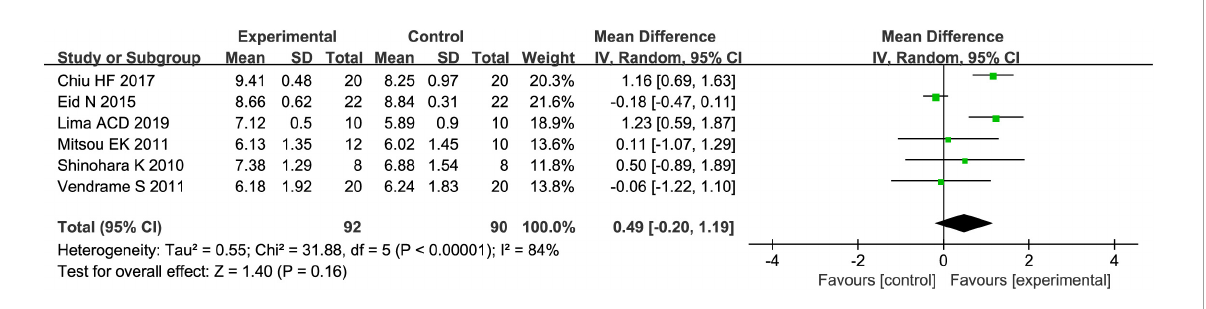
FIGURE8 Intervention effect of different fruits vs. placebo for Lactobacillus acidophilus on patients.